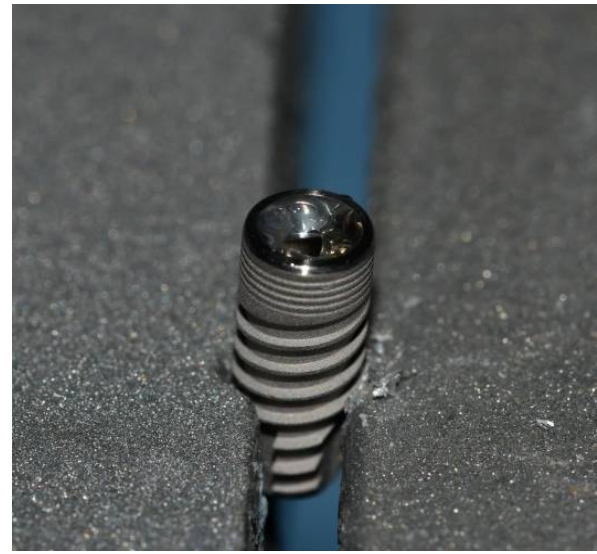
Figure 2. Dental implant fixed in a sterile stainless-steel clamp.